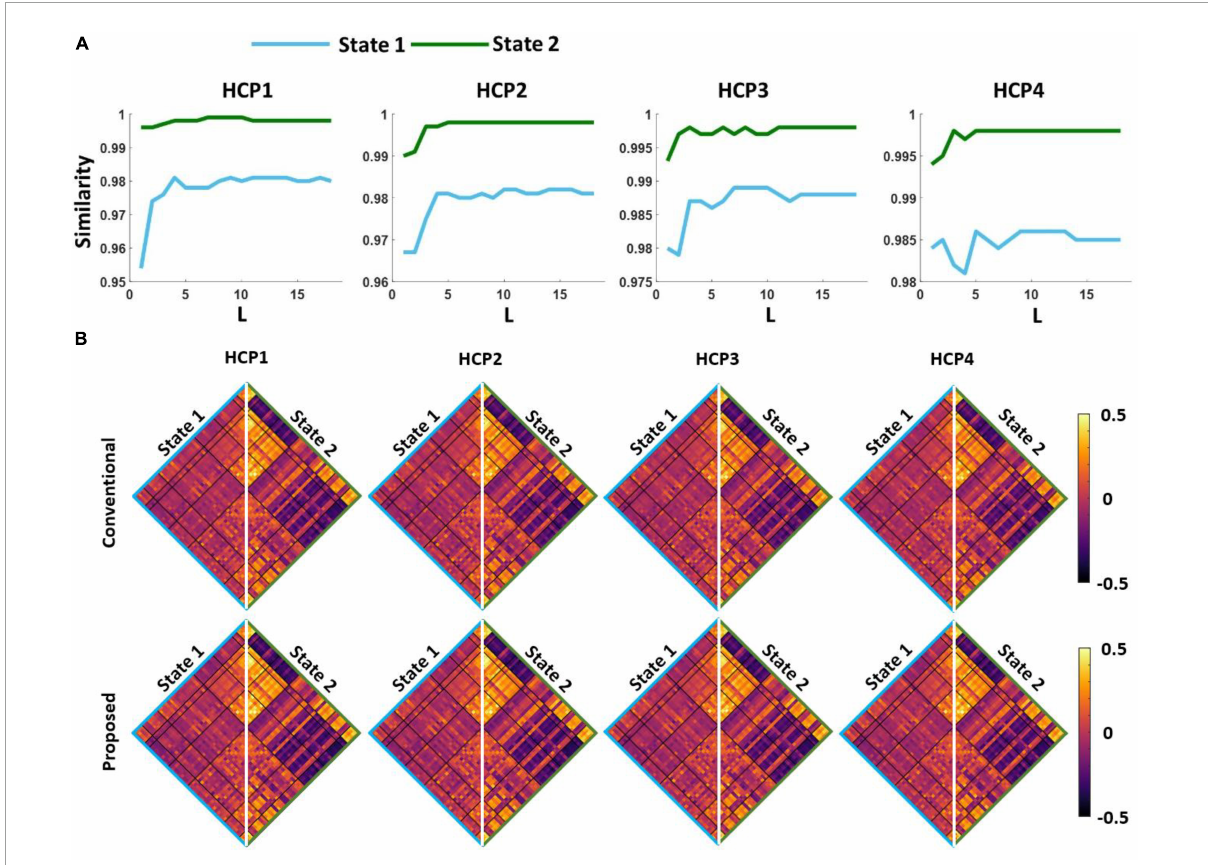
FIGURE4 The estimated dFNC states with the proposed and conventional pipeline for all HCP datasets. (A) We swept the L -value in the first kmeans clustering and calculated the similarity between the estimated states with new and conventional method. For any L > 5, we did not find a significant improvement in the similarity between two clustering methods. (B) Both new and conventional pipeline generated similar dFNC states in all four HCP